Question: Condense the content of this figure into a single sentence.
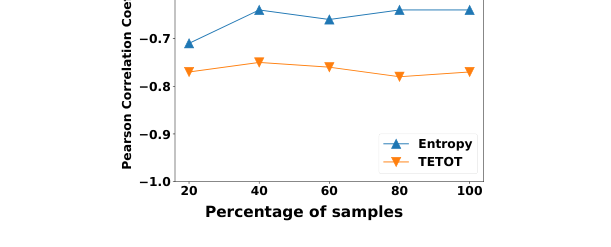
Answer: The Pearson correlation coefficient between transfer- ability and TETOT remains high and better than entropy (a higher negative correlation is better i.e., a smaller number is better) for different sample sizes of the source and target domains.